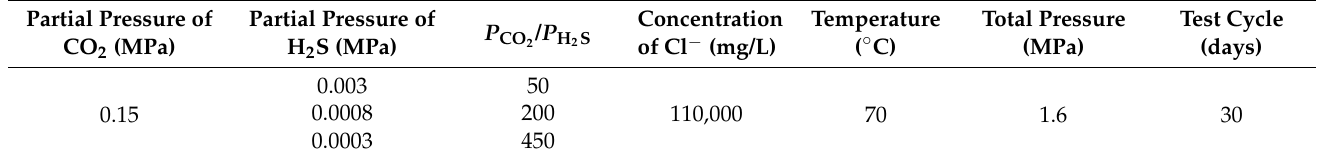
Table 4. Experimental conditions 2.